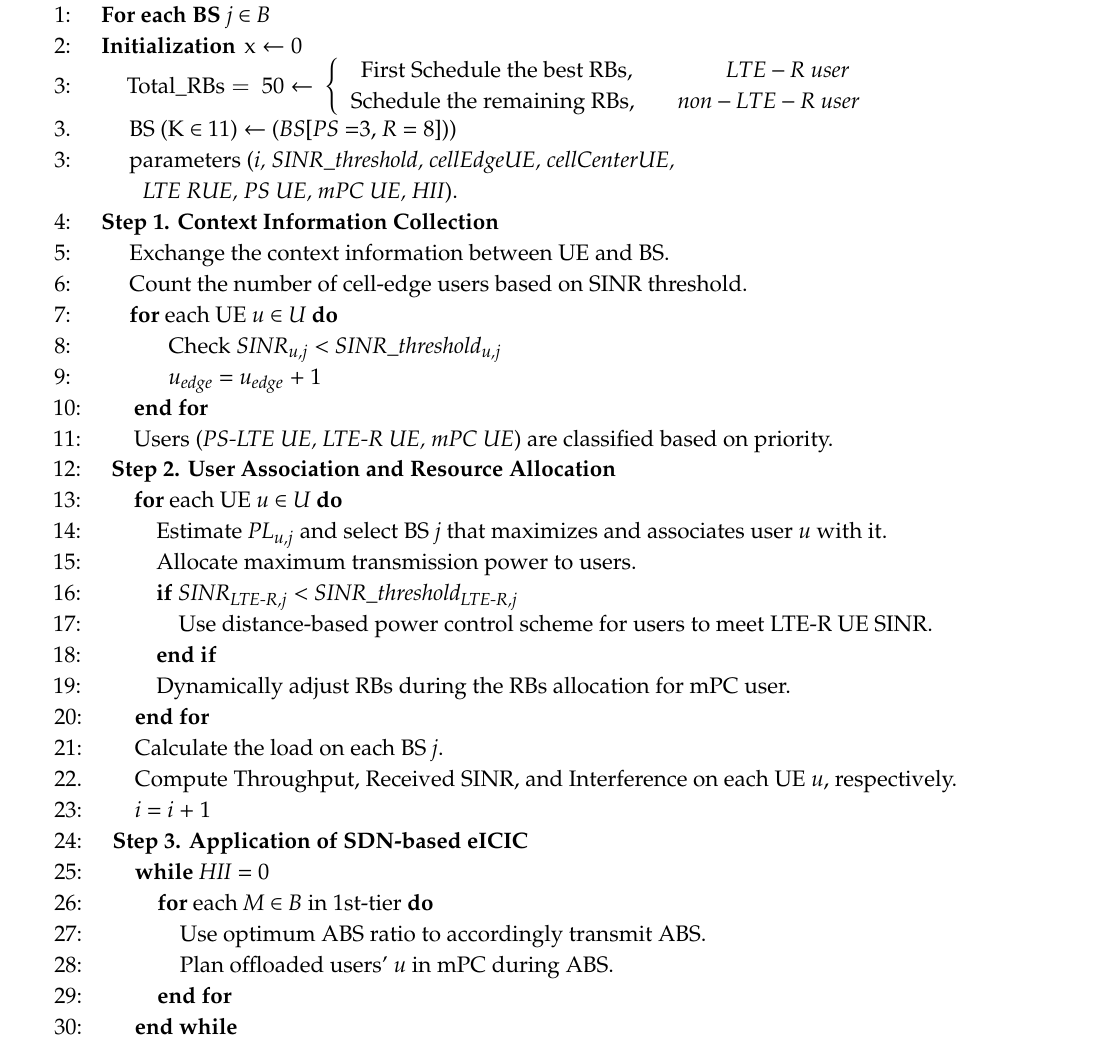
Algorithm 1. Proposed QoS priority-based mPC deployment